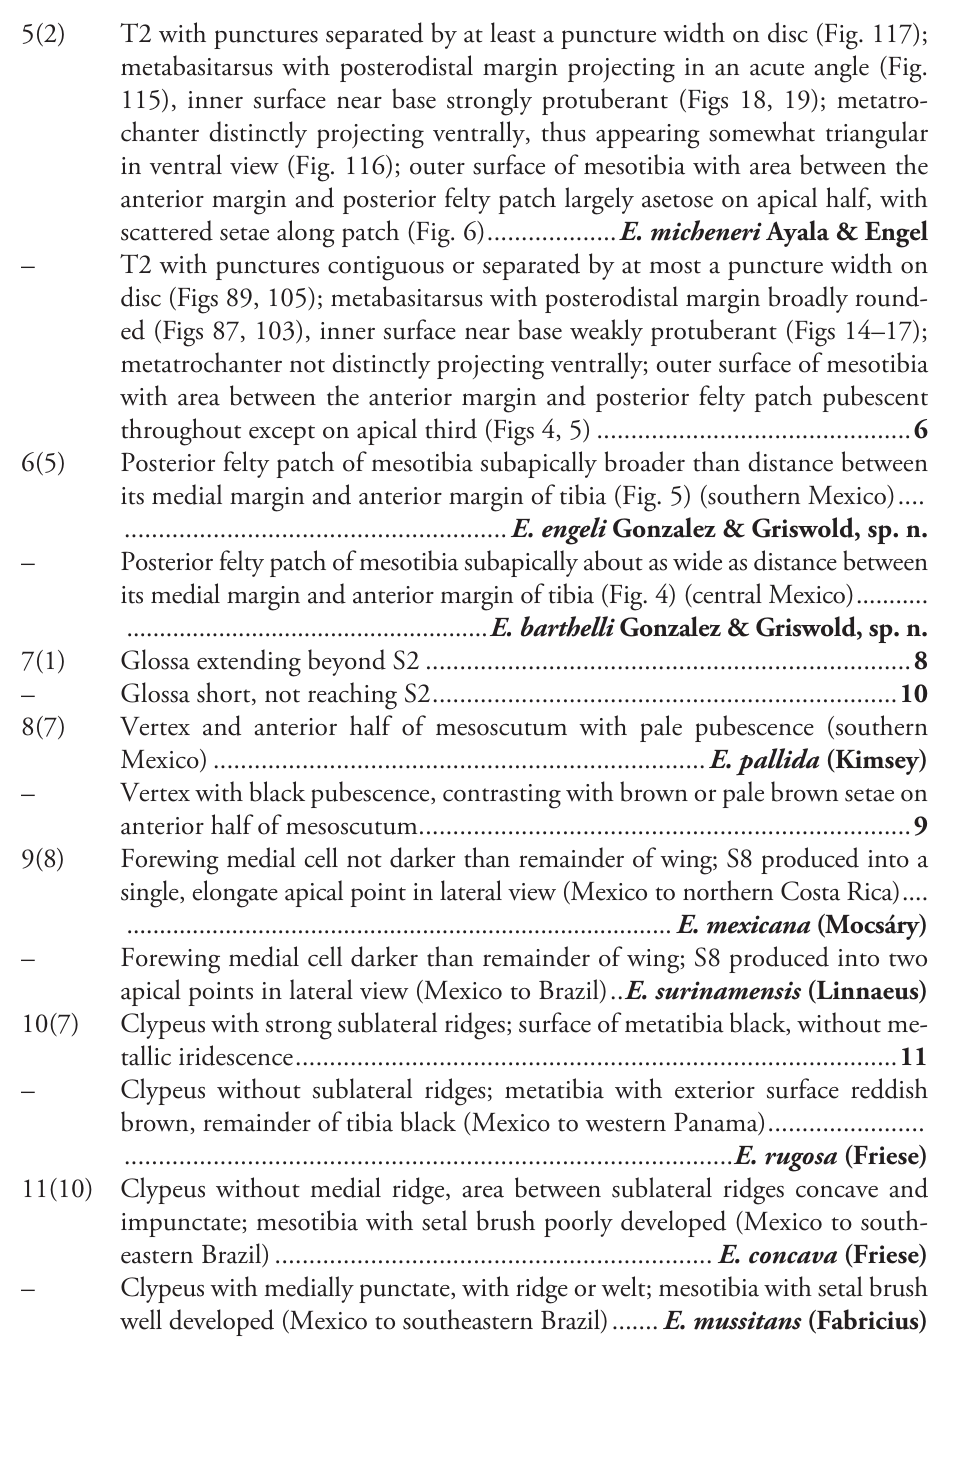
Clypeus without medial ridge, area between sublateral ridges concave and impunctate; mesotibia with setal brush poorly developed (Mexico to south- – Clypeus with medially punctate, with ridge or welt; mesotibia with setal brush well developed (Mexico to southeastern Brazil) ....... E. mussitans